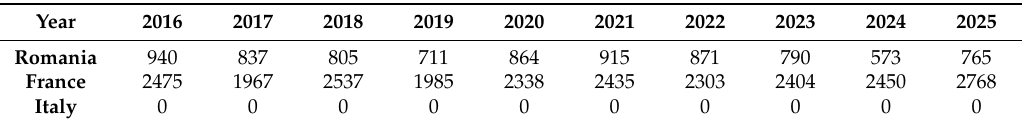
Table 6. The estimated potential of bioethanol from sugar beet (million liters of absolute alcohol). Source: authors’ own calculation based on [56].